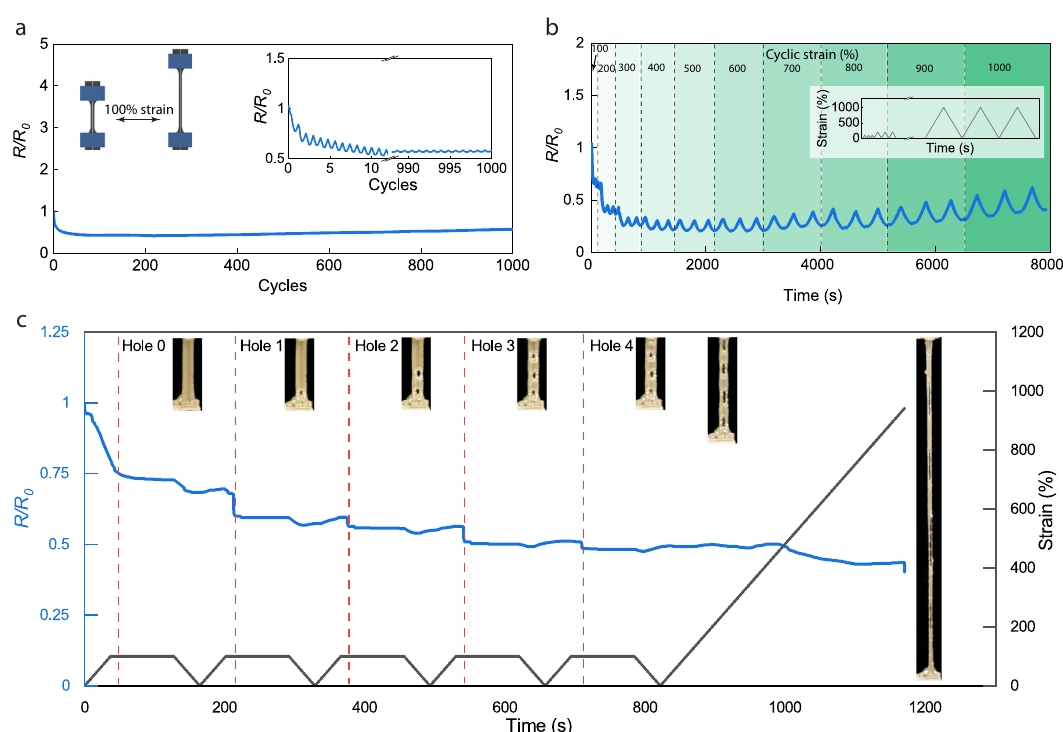
Fig. 4 Robust operation and dynamic self-healing. a Plot shows the robust cyclic behavior of the composite over 1000 cycles, each up to a 100% strain. b Plot of R / R 0 vs. time in a cyclic test of three cycles at each step up to a strain of 1000% in 100% strain increments (shading indicates the three cycles at a given strain), inset shows the applied strain pro fi le vs. time. c Hole-punch test during tension shows the dynamic self-healing capability. A plot of R / R 0 with respect to strain and time shows the reduction in resistance, but shows no loss in electrical conductivity. The composition for all samples in this fi gure is ϕ = 60%, δ =